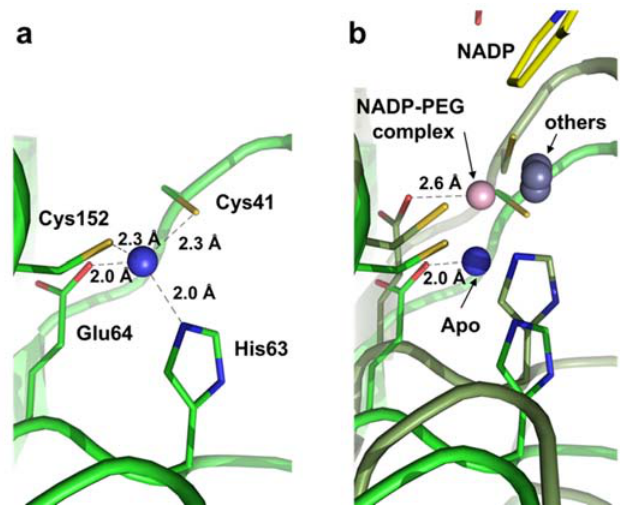
Figure 3. Catalytic zinc coordination. ( a ) Catalytic zinc coordination and its coordinated residues in the apo structure. The blue sphere indicates a zinc ion of Ec YjgB. ( b ) Catalytic zinc coordination of superposed apo and NADP complex structures. The blue and light ‐ pink spheres indicate the catalytic zinc ions of apo and NADP complex, respectively. The apo and NADP complex structures are drawn by green and dark ‐ green cartoons, respectively.